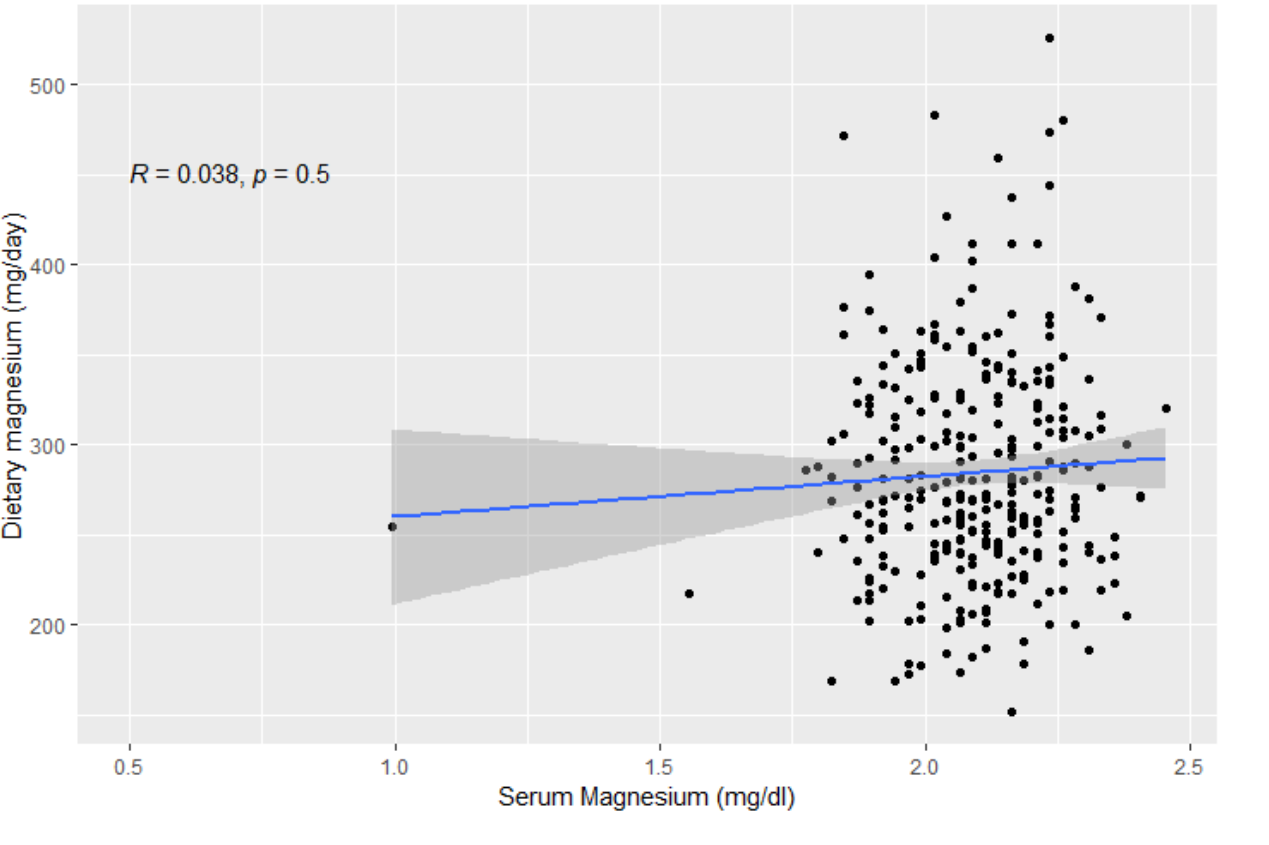
Figure 2. Correlation between serum and dietary magnesium, as assessed by Spearman correla- tion .